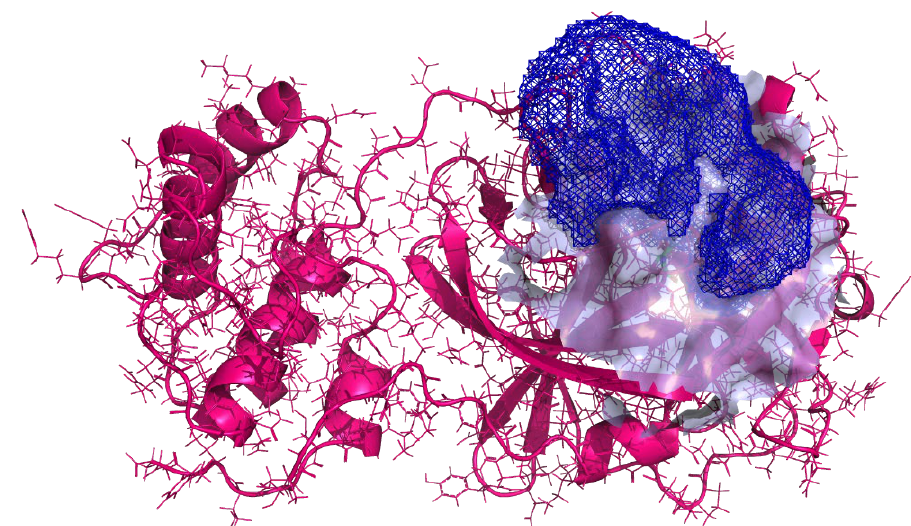
Figure 3. Generated receptor volume with the 3CL pro PDB ID: 6Y7M, the active site near the Cys145 residue and the docking volume defined as a sphere of 7 Å around the reference ligand OEW. Protein is depicted as a pink-magenta-coloured cartoon model with residues emphasised in the line model and coloured atoms (carbon in green, oxygen in red, nitrogen in blue and hydrogen in white colour) with a blue-white transparent active site surface. Docking volume boundary mesh is depicted in blue colour. Isomesh (0.99) was constructed using PyMol 2.1.0 using a grid calculated with cmgrid software (v 0.1.1).